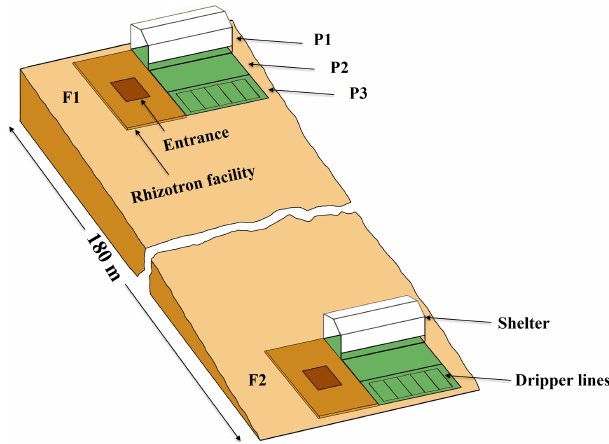
Figure 1. Sketch map of the location and the setup of the upper (F1, stony soil) and lower (F2, silty soil) rhizotron facilities. P1, P2, and P3: the sheltered, rainfed, and irrigated